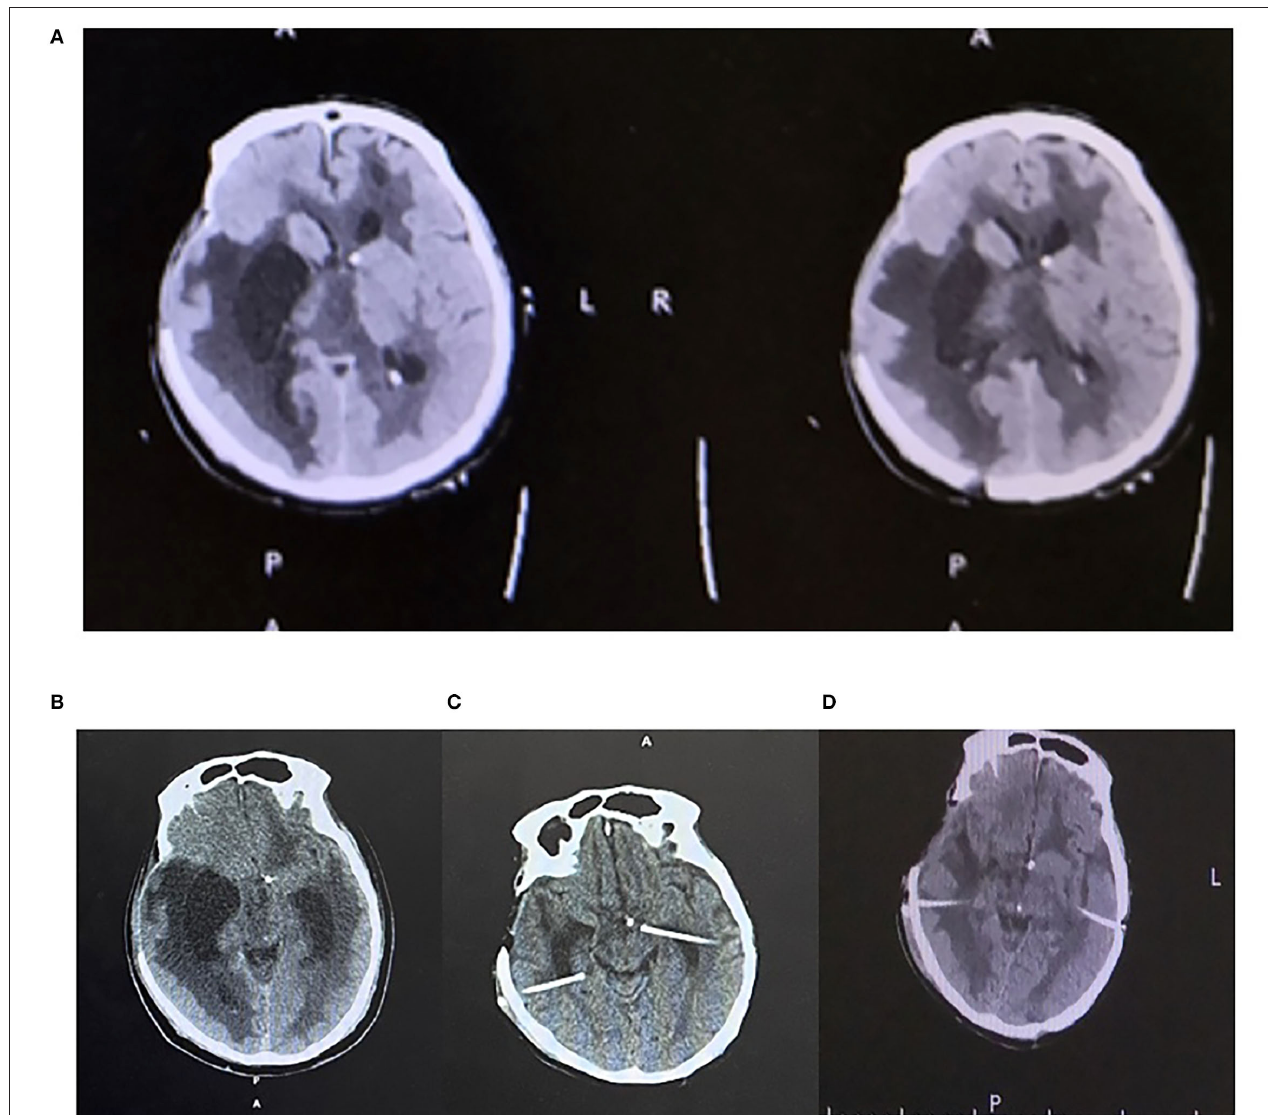
FIGURE 2 | (A) Axial plane CT head showing multiple loculations in the ventricle. (B) Axial CT head showing enlarged ventricles prior to B/L shunt. (C) Axial head CT showing ommaya pump placement on B/L temporal horns. (D) Axial head CT after B/L VP shunt